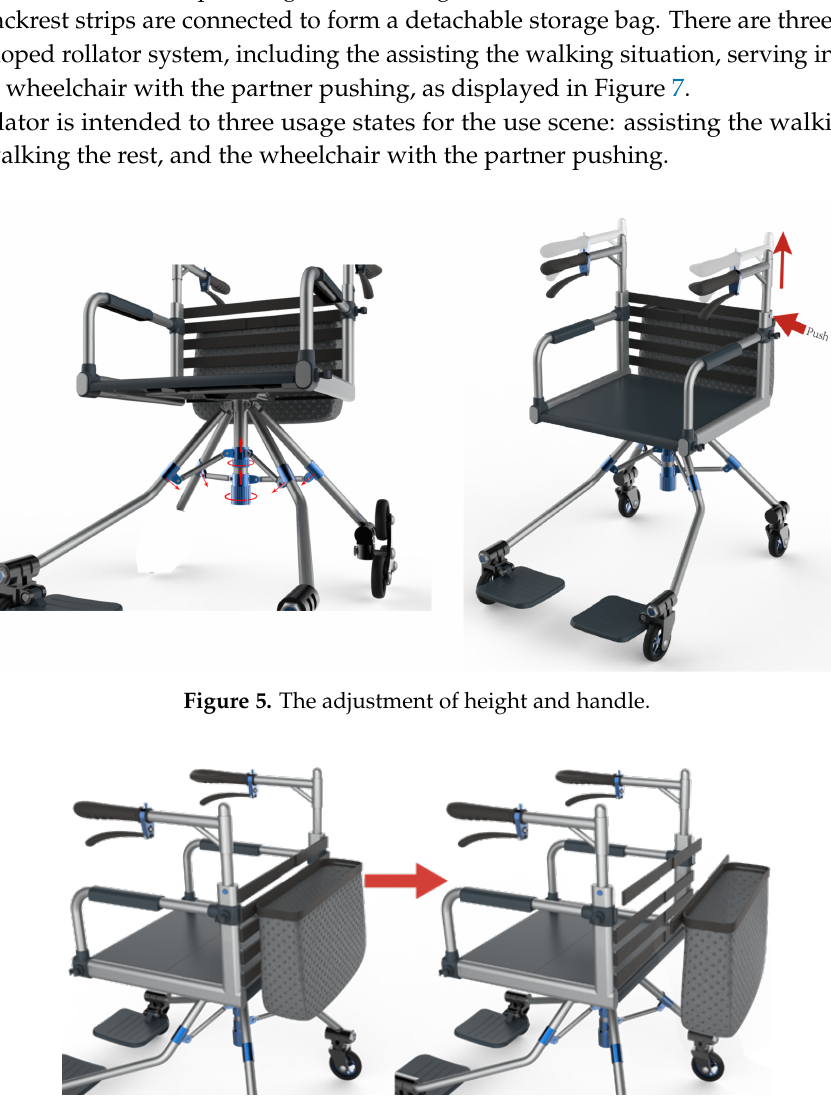
Figure 6. Flexible storage